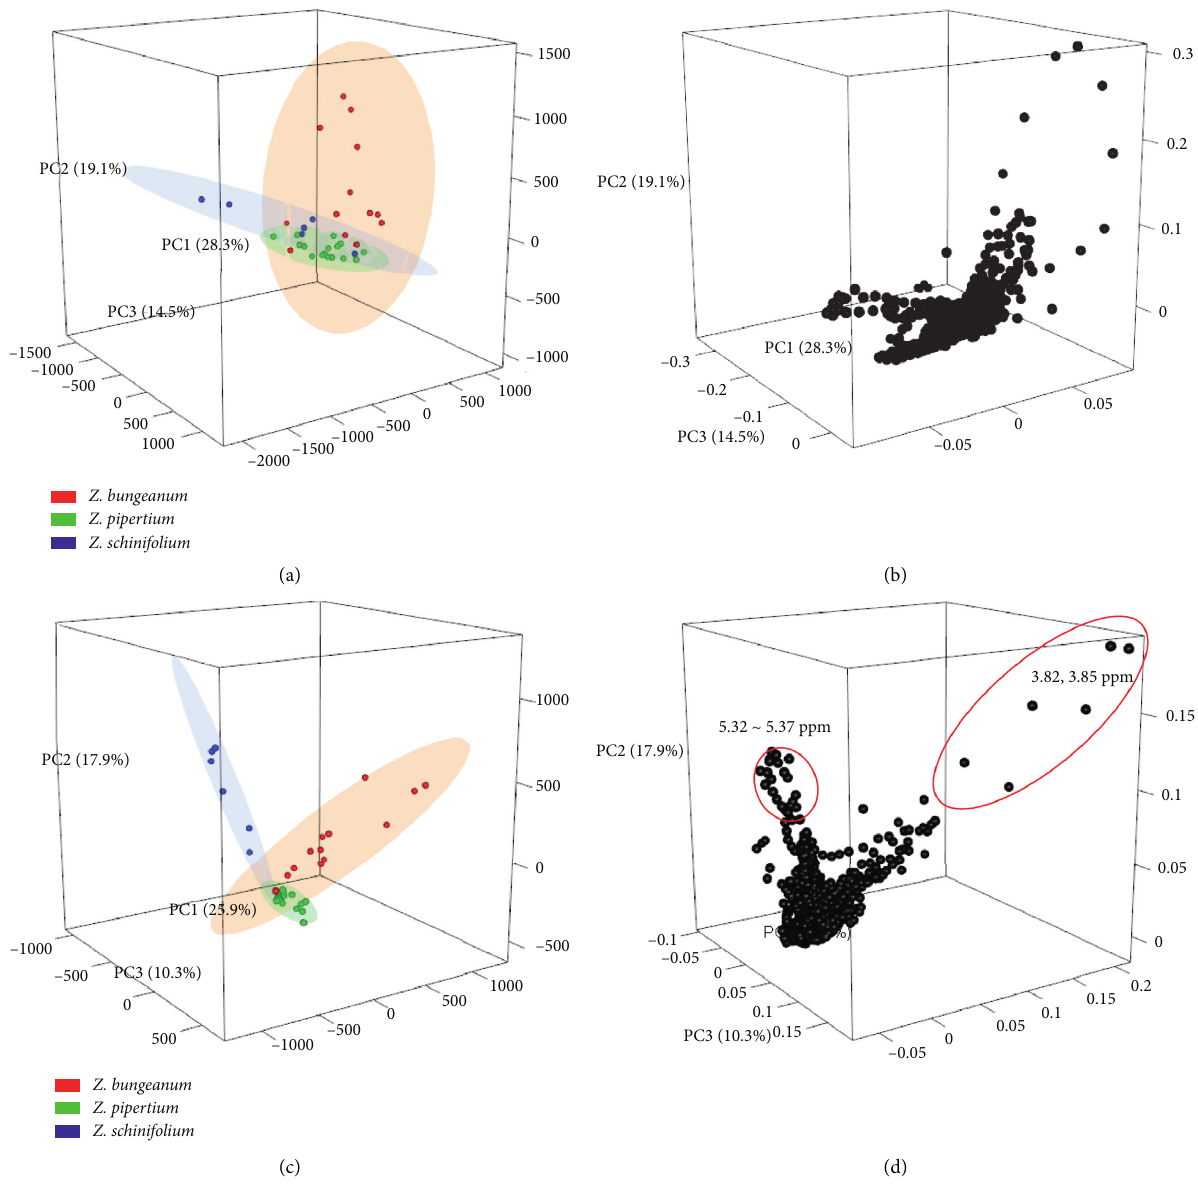
Figure 2: The multivariate plots of three Zanthoxylum species based on the 1 H NMR spectra. (a) The PCA score plot with 95% density ellipses. (b) The PCA loading plot. (c) The PLS-DA score plot with 95% density ellipses. (d) The PLS-DA loading plot. The red circles in the PLS-DA loading plot show the variables contributing to the separation of Z . bungeanum and Z . schinifolium samples. Table 1: Precision for 1 H NMR signals of xanthoxylin for